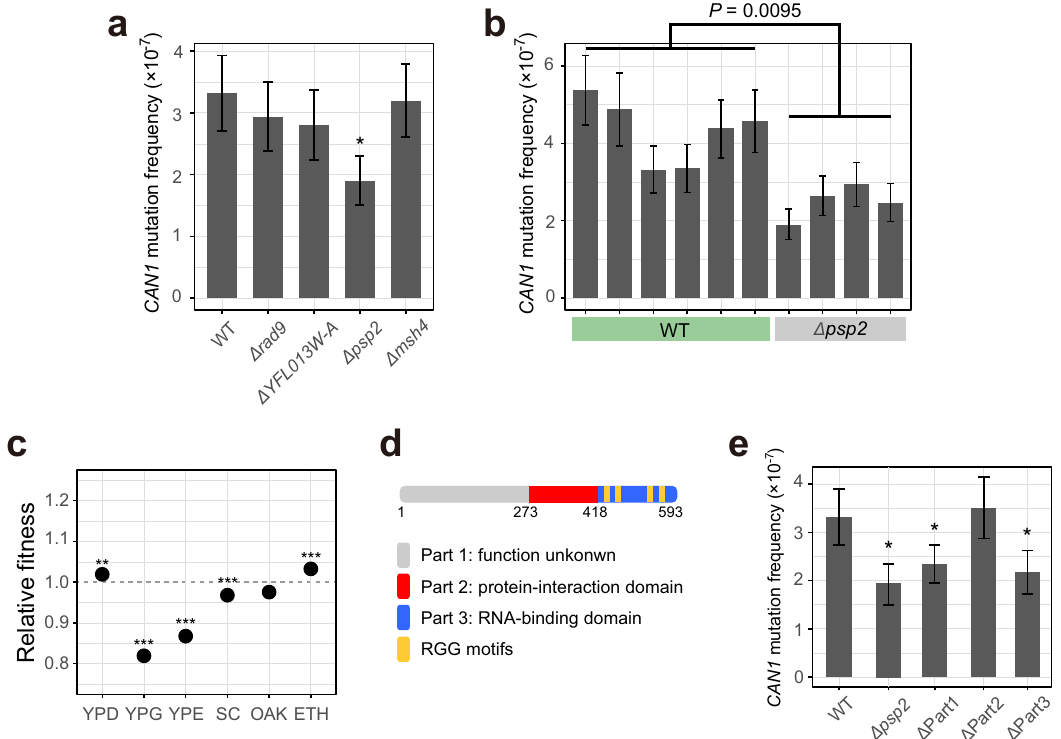
Fig. 3 Discovery of PSP2 as a mutator gene. a CAN1 mutation frequency of gene-deletion strains and the progenitor (WT) based on 72 biologically independent cell cultures from each strain. Bars represent mean estimates, error bars show 95% con fi dence intervals, and an asterisk indicates a signi fi cantly lower mutation frequency than that of the WT ( P < 0.05 based on non-overlapping 95% con fi dence intervals). b CAN1 mutation frequencies of six replicate measures in the progenitor (WT) and four replicate measures in the strain with PSP2 knocked out. Bars represent mean estimates, error bars show 95% con fi dence intervals, and the P value is based on two-tailed Wilcoxon rank-sum test. c The fi tness of the PSP2 -deletion strain relative to that of the WT (dotted line) in six different environments. YPD, rich medium; YPG, glycerol medium; YPE, ethanol medium; SC, synthetic complete medium; OAK, synthetic oak exudate medium; ETH, rich medium with 6% ethanol 32 . ** , Q -value < 0.01, *** , Q- value < 0.001 in the original genome-wide study of fi tness effects of gene deletions 32 . d Functional domains of PSP2 based on the literature. Numbers indicate amino acid positions. e CAN1 mutation frequency in PSP2 -truncation strains based on 72 biologically independent cell cultures from each strain. Bars represent mean estimates and error bars show 95% con fi dence intervals. * indicates signi fi cantly lower than the progenitor (WT) ( P < 0.05 based on non-overlapping 95% con fi dence